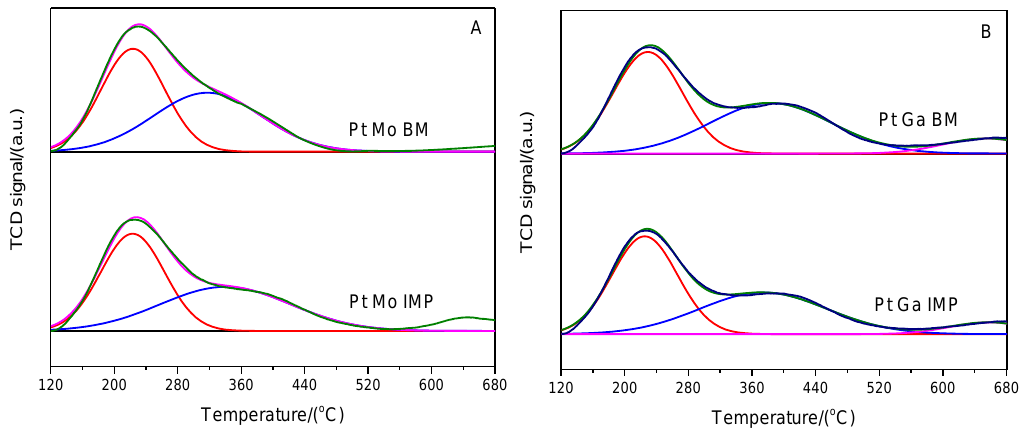
Figure 3. NH 3 -TPD profiles of Pt Mo BM and Pt Mo IMP ( A ), and Pt Ga BM and Pt Ga IMP ( B ) samples.